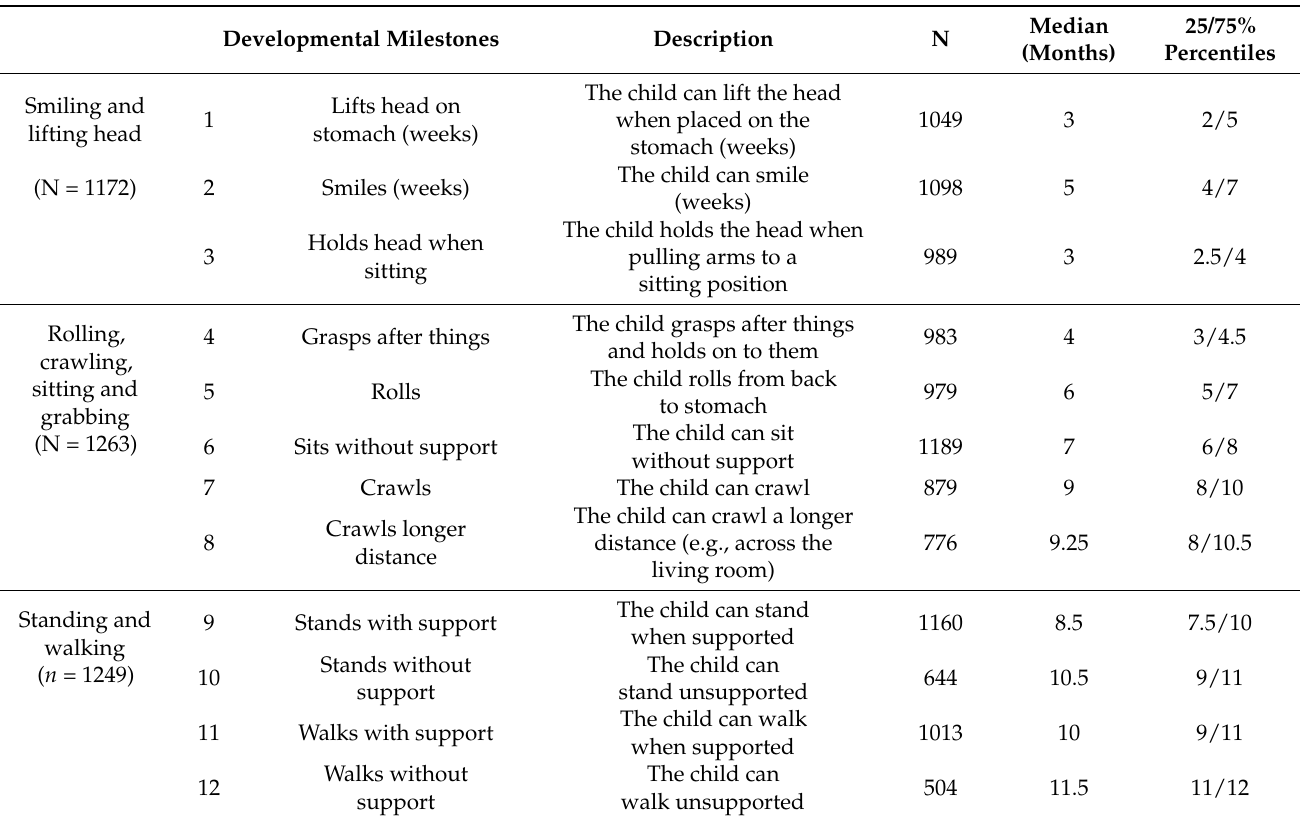
Table 1. Descriptive characteristics of motor developmental